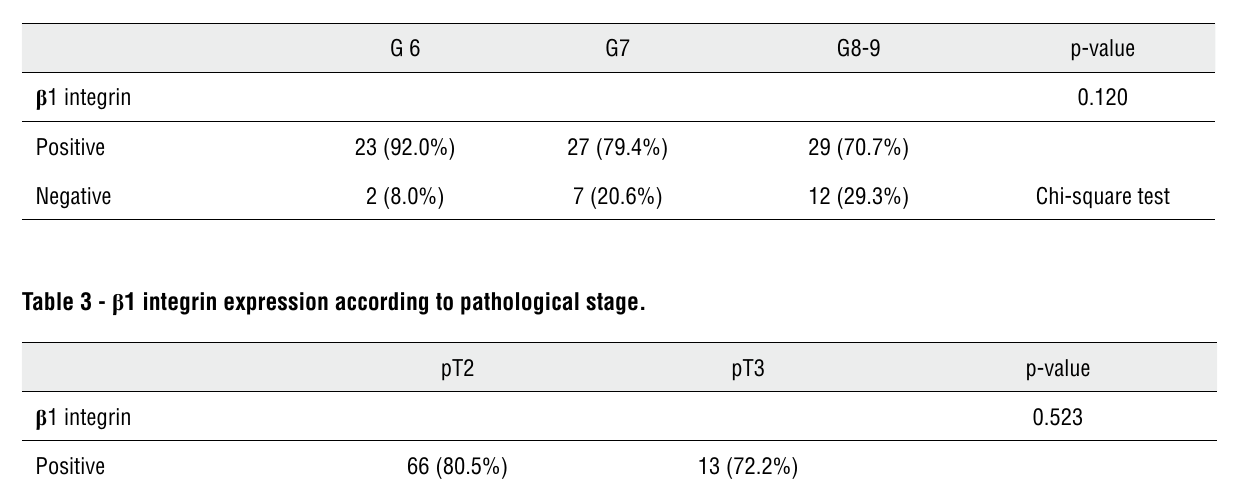
Table 2 - β 1 integrin expression according to Gleason score.